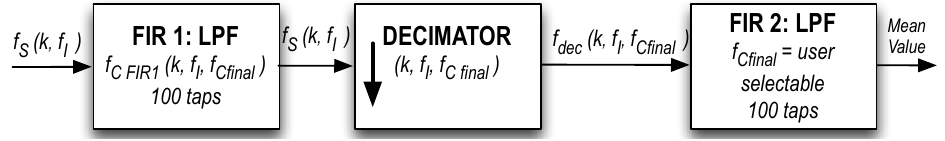
Figure 6. Representation of the adaptive two stage low pass FIR filter implemented in the LabView interface.